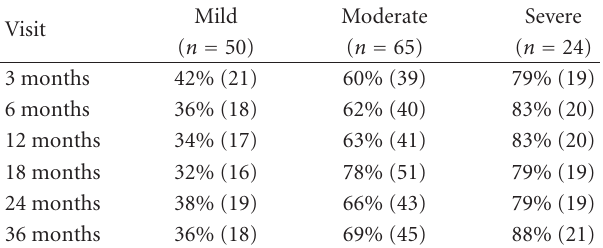
Table 6: Incontinence qualify of life questionnaire ≥ 10-point Im- provement, imputed results by severity at